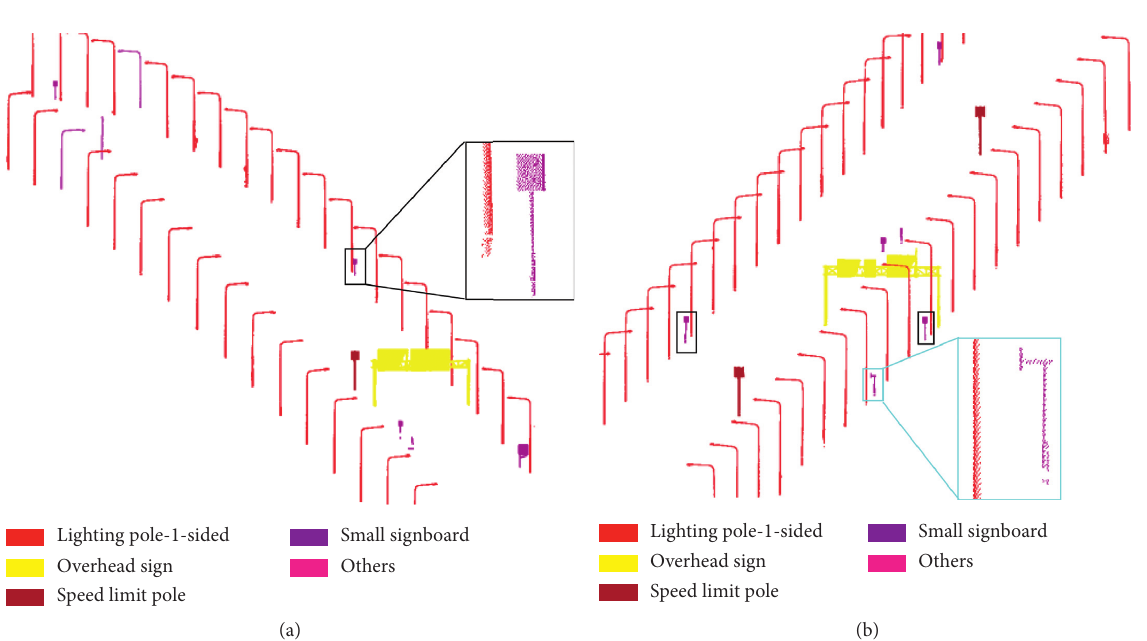
Figure 17: Classification results at Site 1. (a) The light pole was miscategorized due to a short height, and the telephone poles were mislabeled as a small traffic signboard. (b) The bare pole was misclassified as a small traffic signboard.